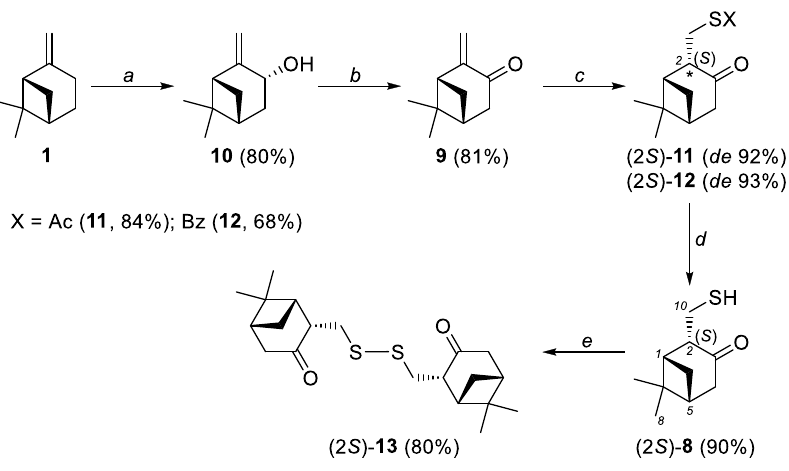
Scheme 2. Synthesis of 10-sulfanyl-isopinocamphone derivatives. Table 1. Effect of reaction conditions on the stereoselectivity of the formation of ( S )-acyl derivatives (2 S )- 11 and (2 S )- 12 ( de ) (synthesis time 5